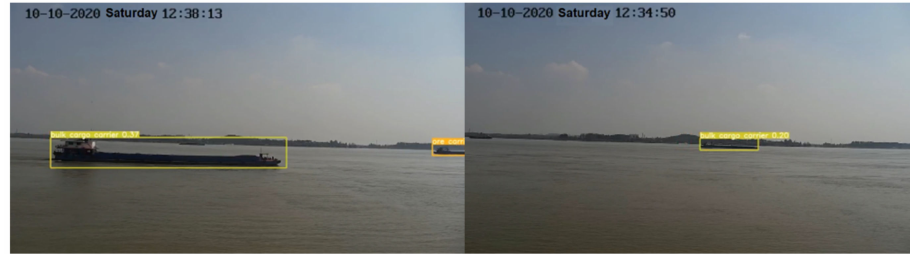
Figure 5. Moving ships’ detection results.